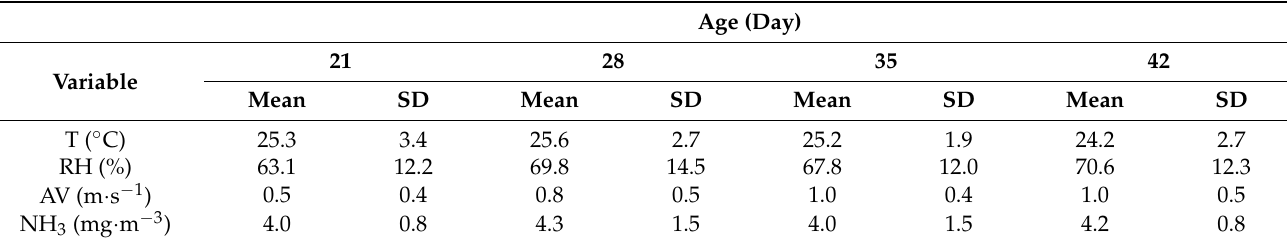
Table 4. Mean values and standard deviation of dry-bulb temperature, relative humidity, air velocity, and ammonia